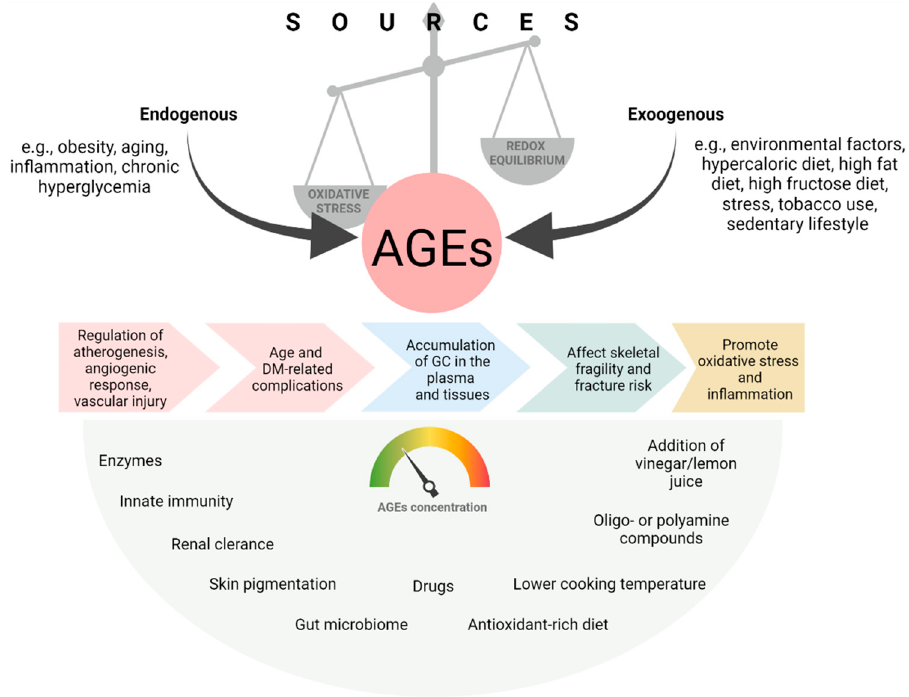
Figure 2. AGE sources, their impact on the human body and on lowering and defense factors. AGE—advanced glycation-end products; GC—glycation compounds.